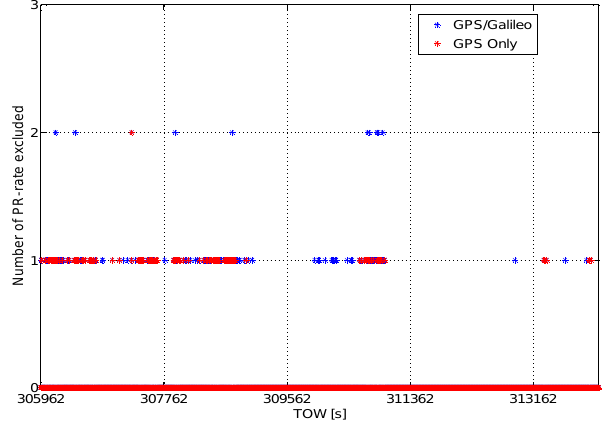
Figure 16. Number of pseudorange-rate observables excluded from the navigation solution as a function of time.